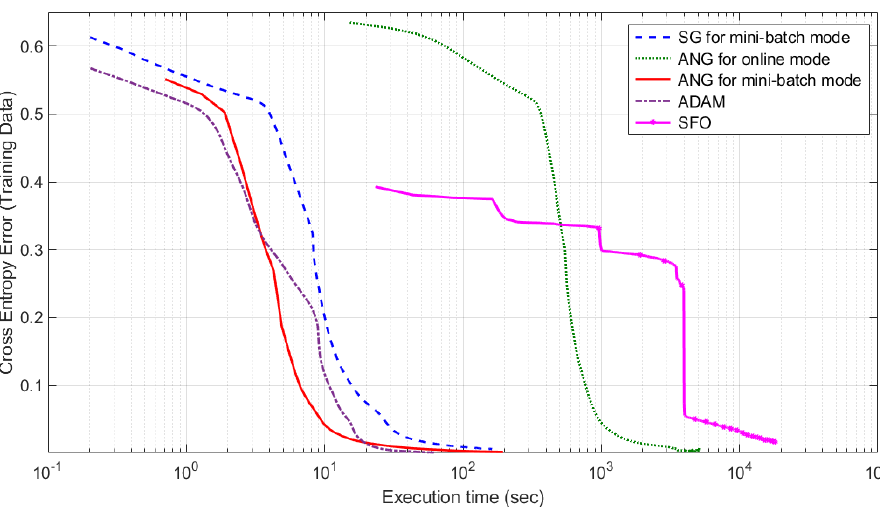
Figure 6. Change of errors for spiral data classification depending on the execution time.